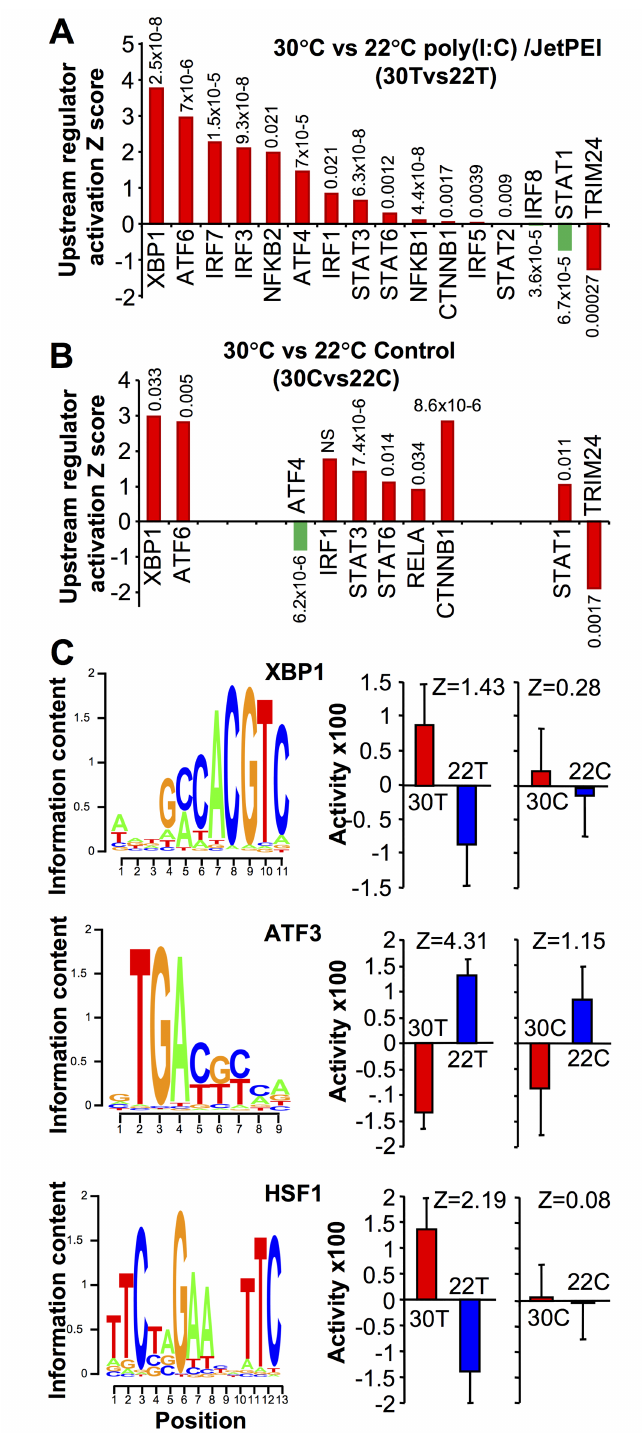
Fig 6. RNA-Seq of feet of mice housed at 30˚C or 22˚C. (A) Mice housed at 30˚C or 22˚C were injected s.c. into feet with poly(I:C)/jetPEI. After 12 hours feet were harvested, mRNA was extracted and subjected to RNA-Seq analysis. Differentially expressed genes (q < 0.01, CPM > 1 in at least 3 samples) were analyzed by the IPA upstream regulator (USR) function (direct only). Selected USRs associated with the type I IFN response are shown ranked by Z score.